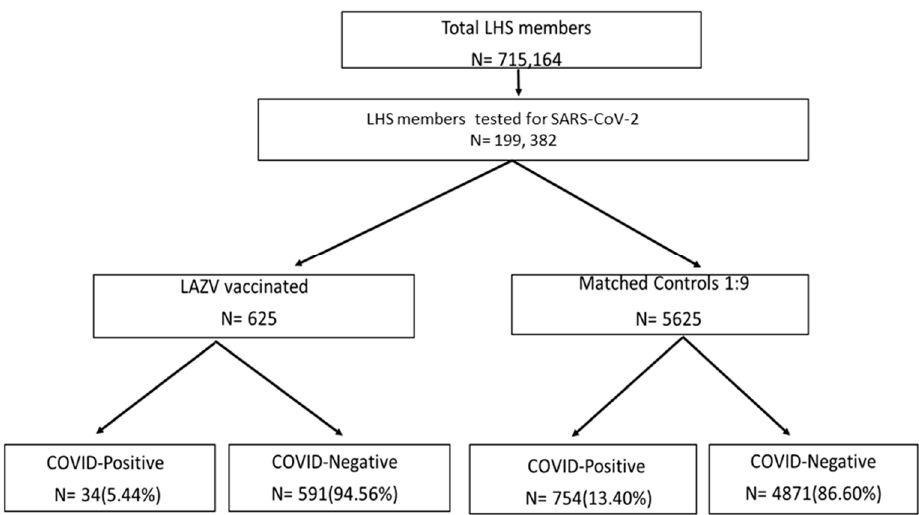
Figure 1. Flowchart of the study design.